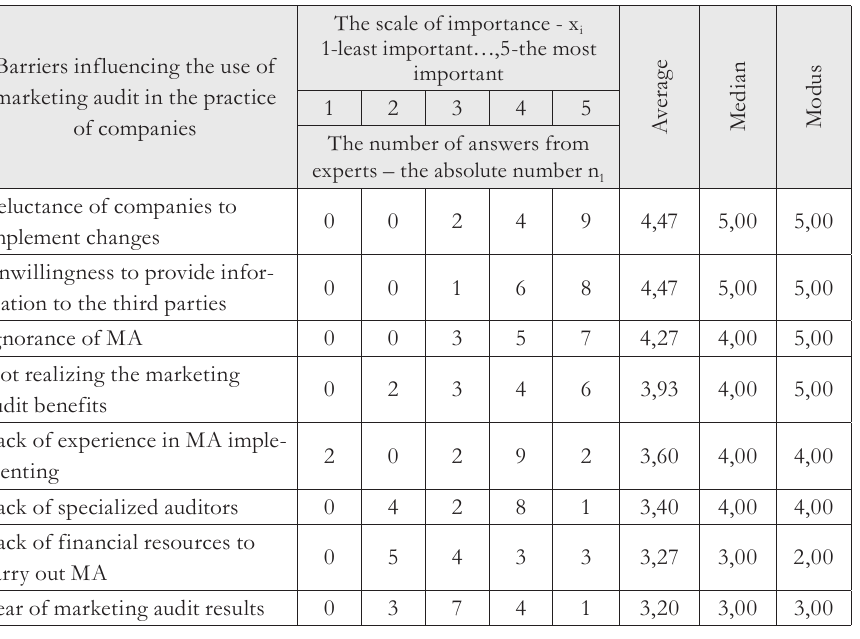
Tab. 2 – The importance of the barriers influencing the use of marketing audit in practice of companies (from an expert point of view). Source: Own